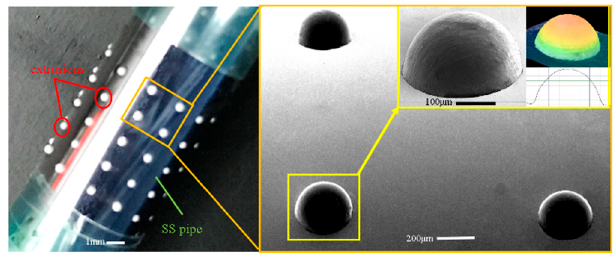
Figure 8. Electroforming mandrel with domed shape extrusion polymer pattern. Micromachines 2020 , 11 , x